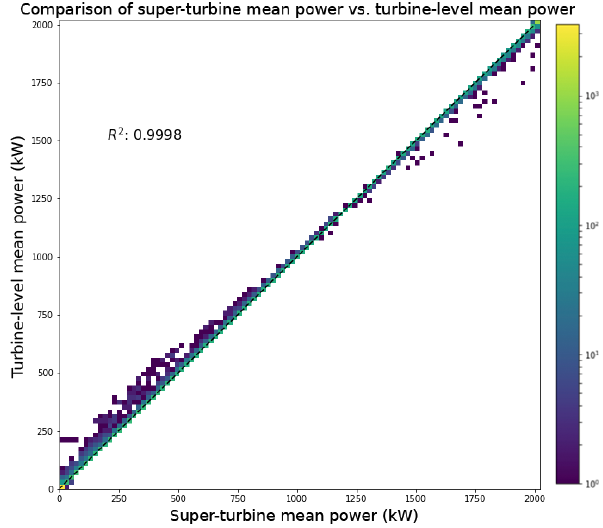
Figure 6. Scatterplot of the super-turbine power conversion to the turbine-level power conversion from the mean wind speed and wind speeds at the individual turbines at the Shagaya wind